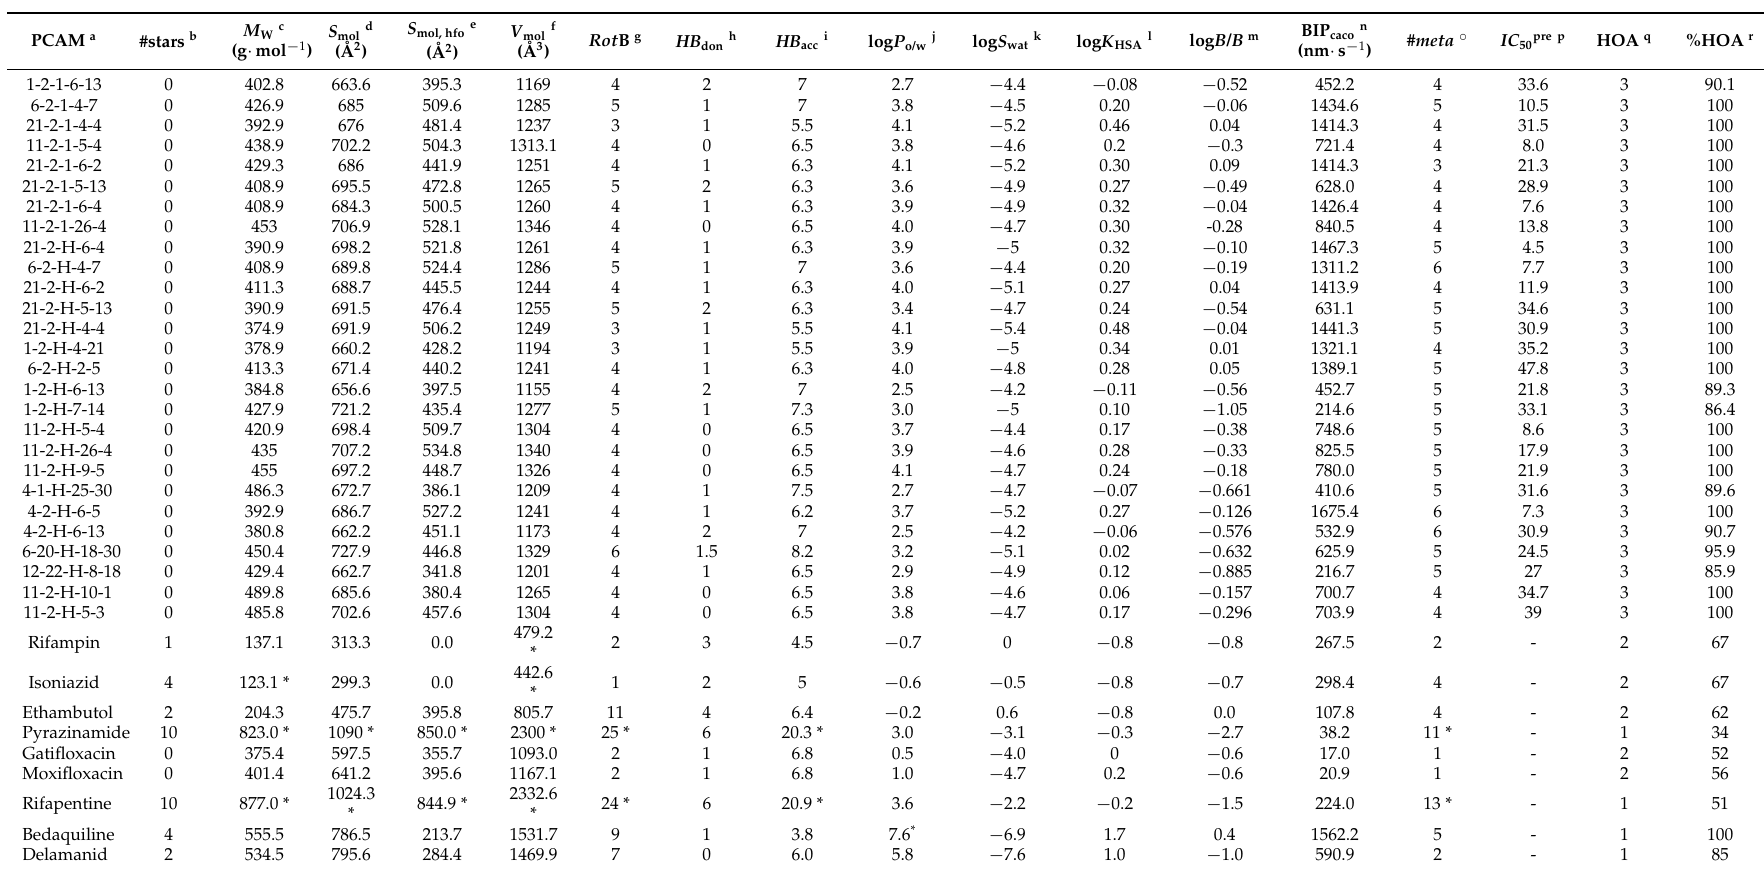
Table 7. Predicted ADME-related properties of the best-designed PCAM analogues and known antituberculotic agents either in clinical use or currently undergoing clinical testing, as computed by QikProp